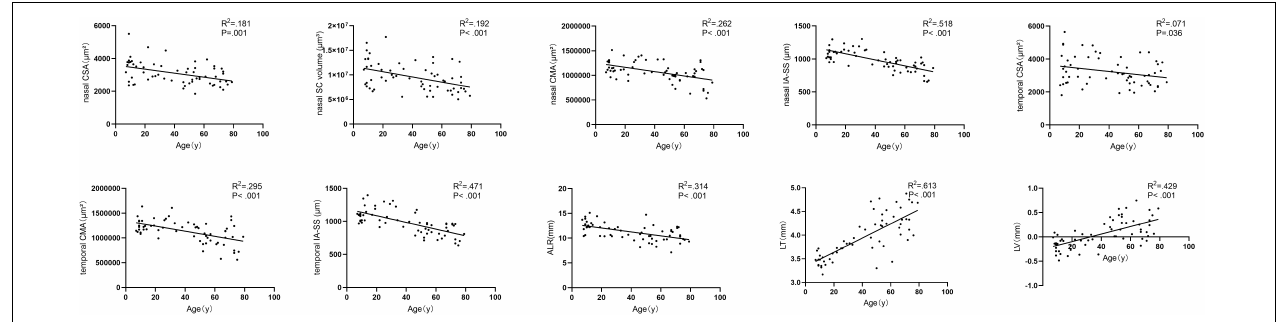
FIGURE 3 | Correlations between nasal, temporal, and lenticular parameters and age.